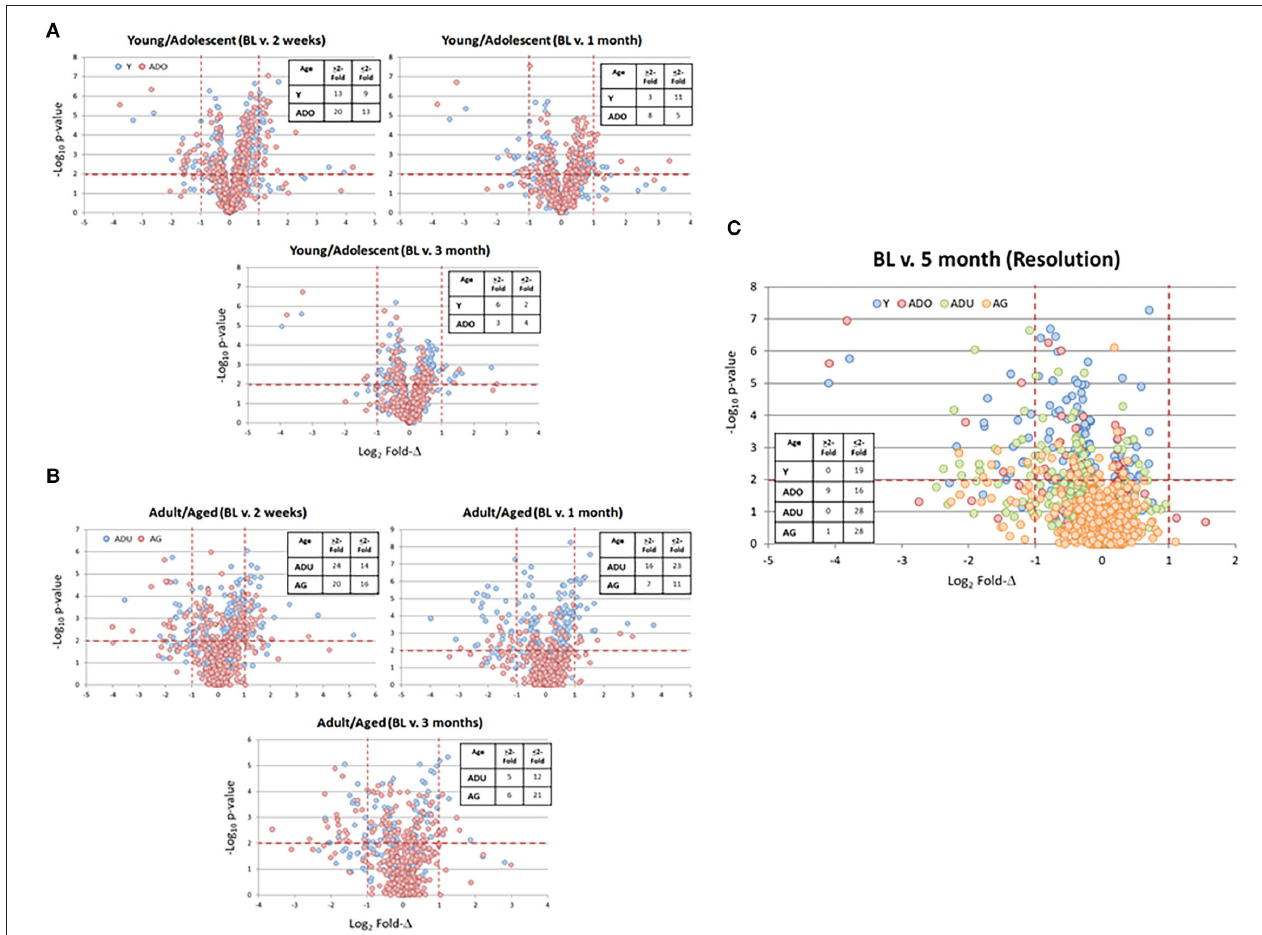
FIGURE 4 | Volcano plots of gene expression differences in young and adolescent (A) and adult and aged (B) animals comparing the 3 time points during disease to the baseline healthy tissues. (C) The gene expression profiles in resolution samples for each of the age groups. Red lines denote p < 0.01 and fold-difference of > 2. Each point denotes the value for one of the 452 annotated genes. The inset tables summarize the number of genes in each age group at each time point that was altered by > 2-fold compared to